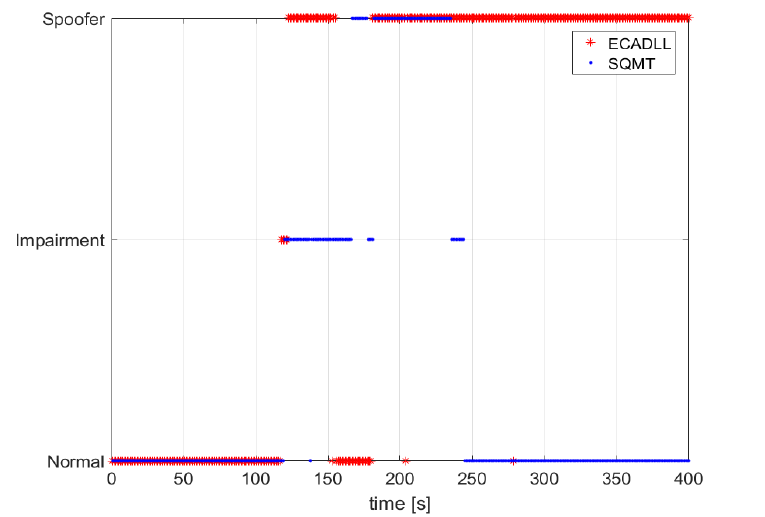
Figure 16. A comparison of the impairment detection using GPS Satellite Number 6 for the static dataset, TEXBAT ds3. In red, the decision made by ECADLL is shown, and in blue, the one using the Signal Quality Monitoring Technique